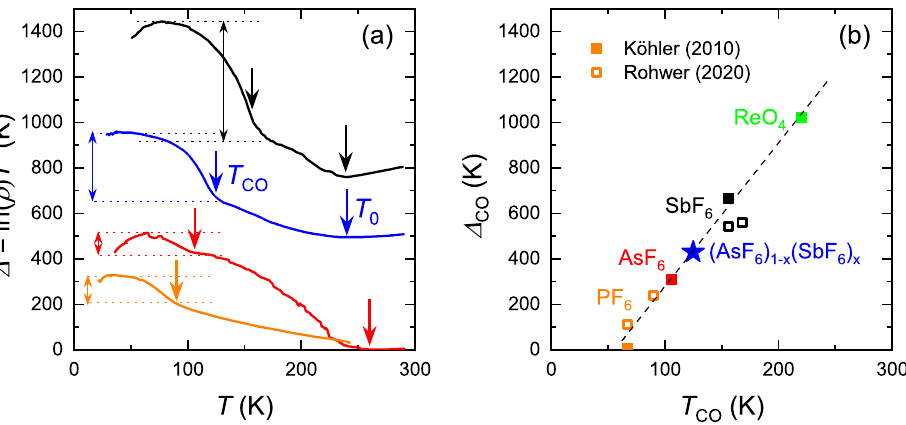
Figure 5. ( a ) Temperature-dependent energy gap of (TMTTF) 2 [AsF 6 ] 1 − x [SbF 6 ] x for x = 0 [37], 0.3, and 1 [37], and for deuterated (TMTTF) 2 PF 6 with T CO = 90 K [39]. The total gap size, measured (cid:113) ∆ 2 + ∆ 2 ( T ) in by the resistivity, increases as ∆ CO adds up in quadrature ∆ ( T ) = T ln ρ = CO CO the CO state. The increase from ∆ ( T CO ) to ∆ max is indicated by double arrows and dashed lines in respective colors. The curves have been vertically shifted; by definition ∆ ( T 0 ) = 0. ( b ) ∆ CO of (TMTTF) 2 [AsF 6 ] 1 − x [SbF 6 ] x (blue star) is plotted versus T CO together with the data (solid squares) of (TMTTF) 2 X with X = PF − , AsF − , SbF − and ReO − [37]. Open squares indicate measurements 6 6 6 4 on pristine and deuterated PF − and SbF − compounds [39]. The data follow an approximately 6 6 linear relationship until ∆ CO vanishes for T CO ≤ 60 K. Alternatively, this universal behavior can be interpreted as a negative ∆ CO for T CO →